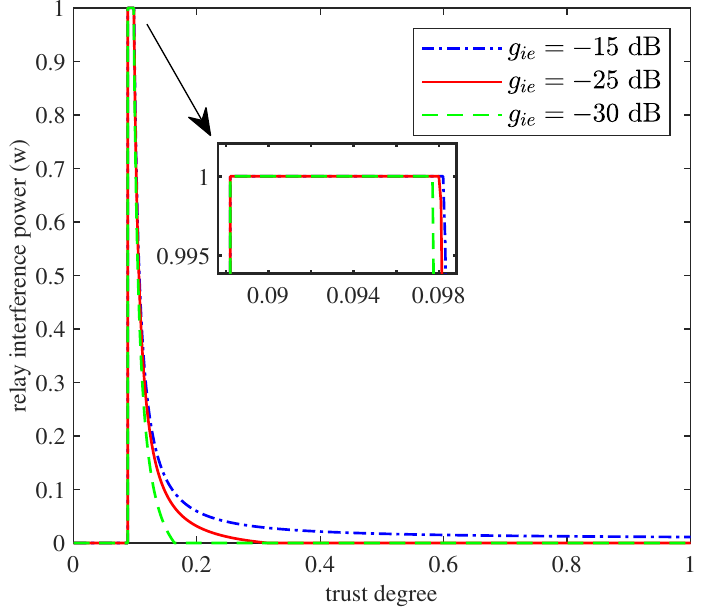
Figure 4. Relay interference power versus trust